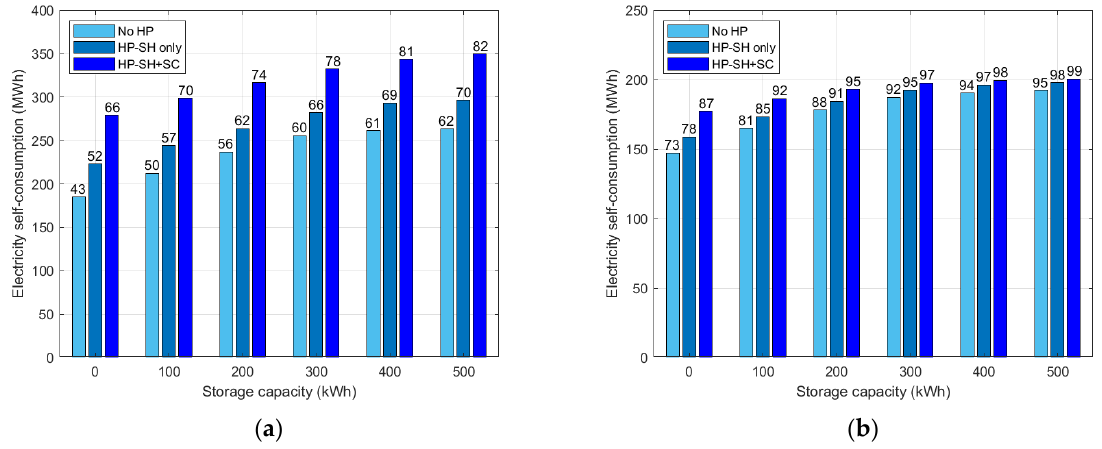
Figure 7. Self-consumption with storage system: ( a ) scenario S1; ( b ) scenario S2.